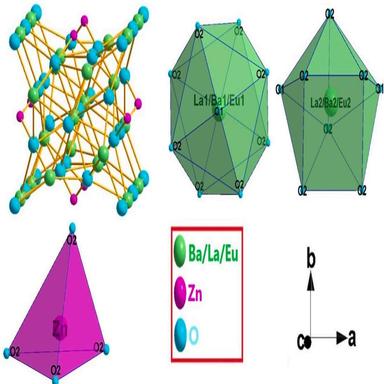
The crystal structure of the fabricated Eu3+ doped Ba2La4Zn2O10 nanophosphor and coordination spheres of different types of atoms present when viewed along the c-axis.